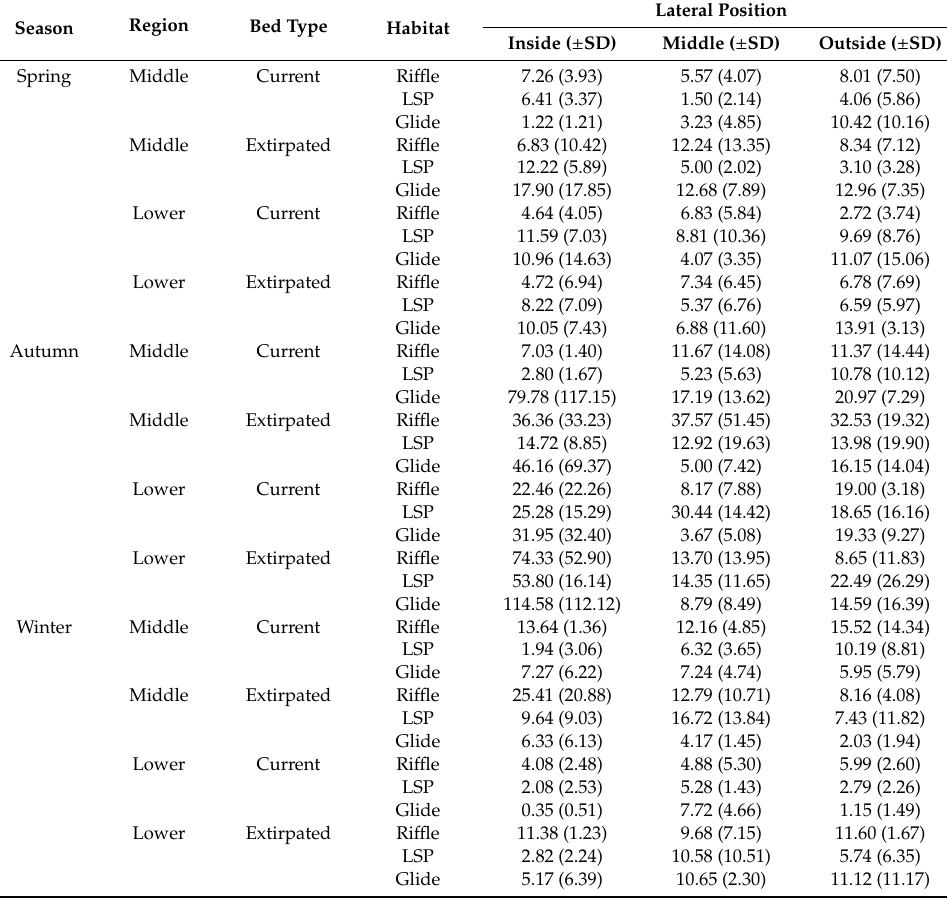
Table A4. Pooled mean shear stress (N / ms) ( ± SD) by lateral position (Inside, Middle, Outside) across seasons (Spring, Autumn, Winter), regions (Middle, Lower), bed type (Current, Extirpated), and habitat (Ri ffl e, LSP,